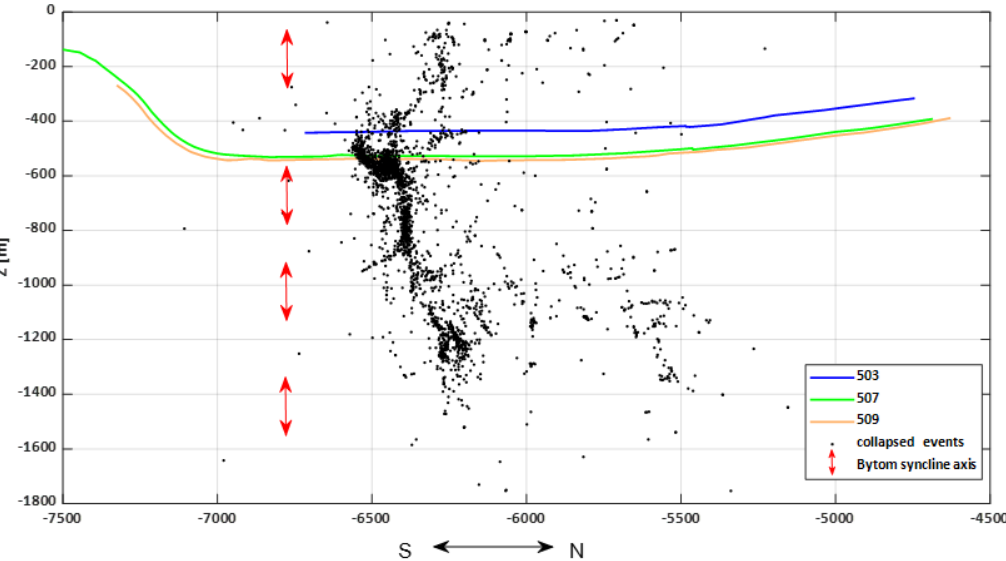
Figure 8. Vertical cross-section of seam 503 and previously mined seams 507 and 509 located below along with the location of event sources after relocation as well as the axis of the Bytom basin.